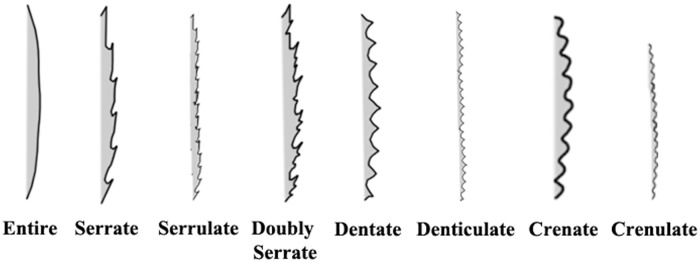
Leaf margin type.